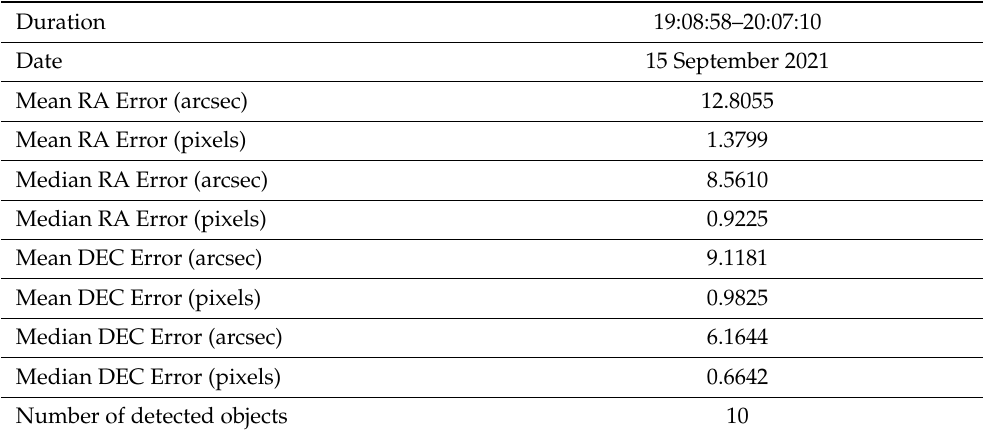
gular coordinates. The error statistics are shown in Table 3. Table 3. Error statistics for the telescope Table 3. Error statistics for the telescope sequence.